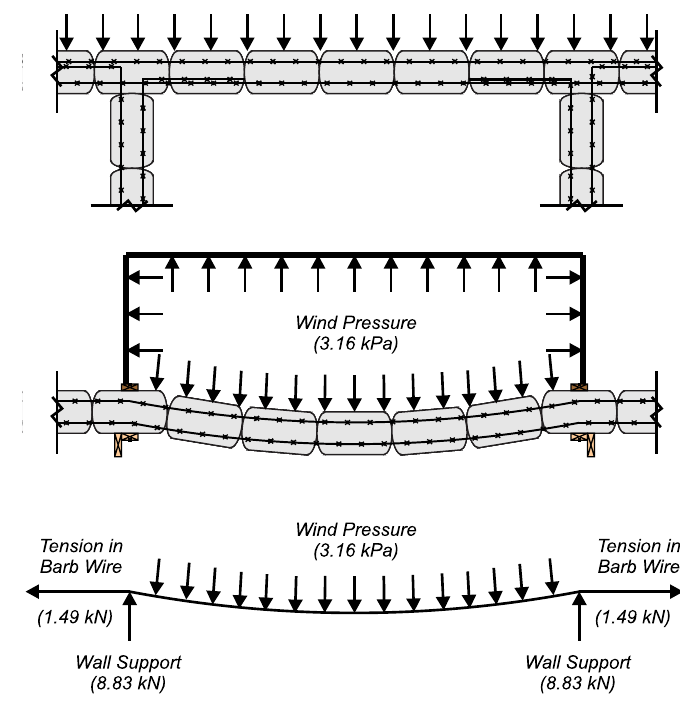
Figure 10. Plan view of earthbag structure ( top ); plan view of test wall ( middle ); estimated forces in barbed wire and wall supports at peak pressure ( bottom